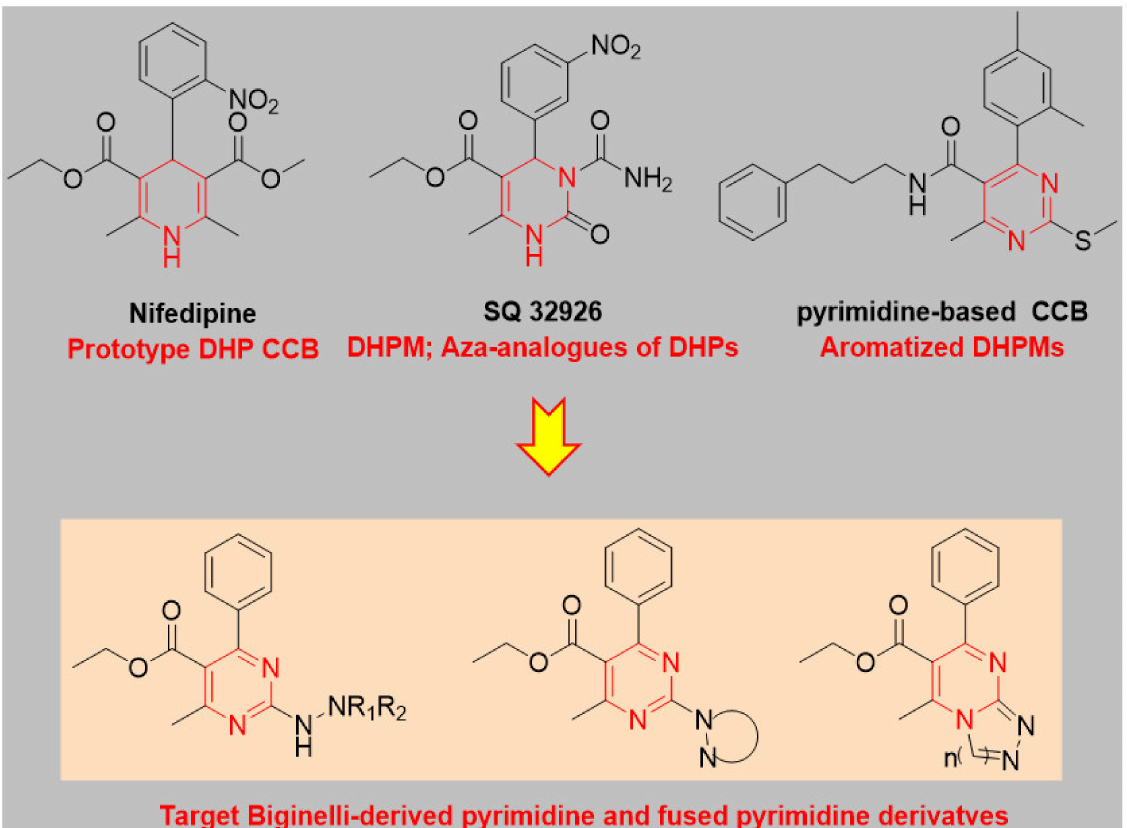
Figure 2. The design strategy of the target Biginelli-derived pyrimidines and fused